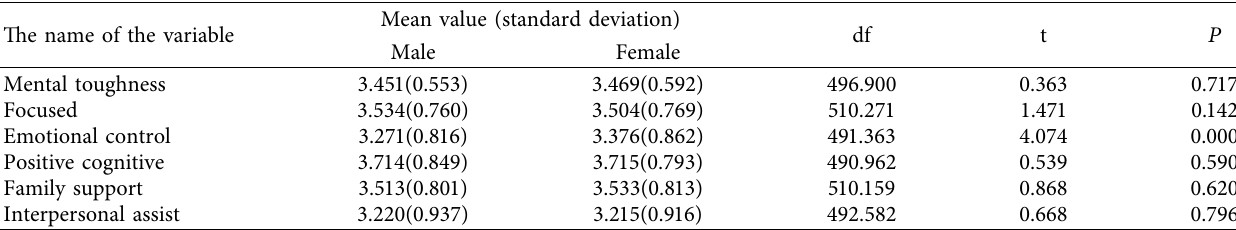
Table 2: Summary of difference analysis of mental toughness of middle school students with different genders.